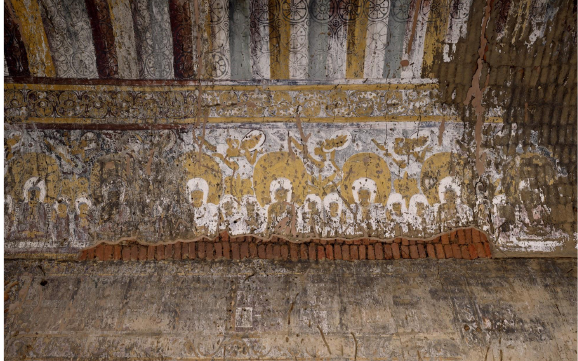
Figure 5. Render of interior wall painting photogrammetry in